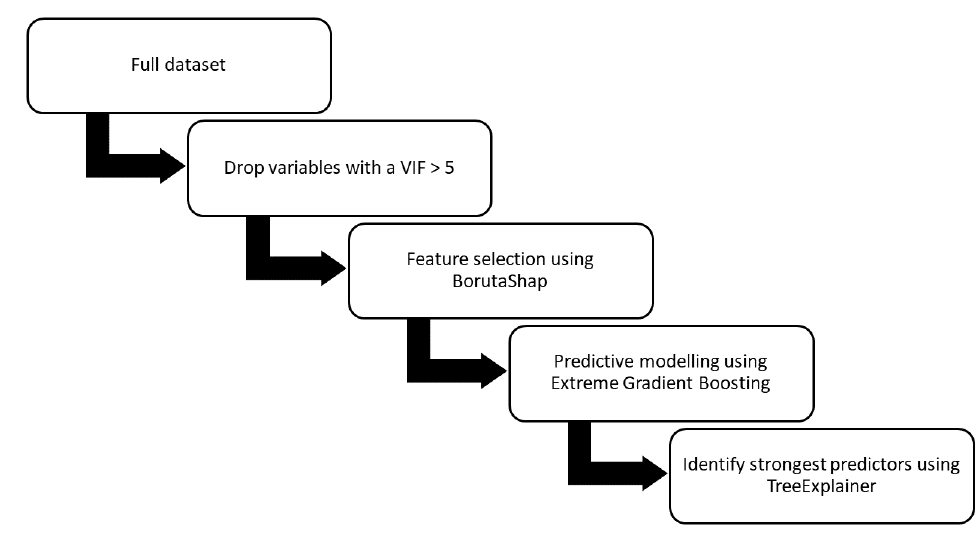
Figure 1. Graphical illustration on the workflow used for this